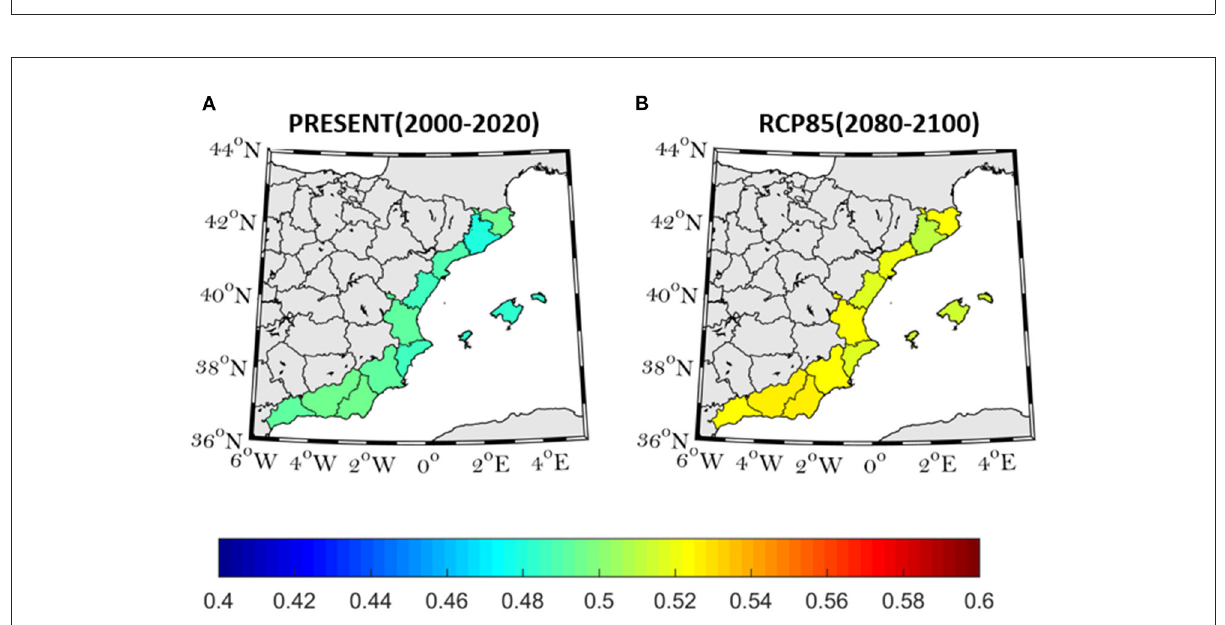
FIGURE9 Final risk of the impact chain 2, corresponding to the “Risk of loss of attractiveness due to a reduction of beach availability”. For (A) present conditions (2000–2020) and (B) for the end of the century (2080–2100) under RCP85 scenario.